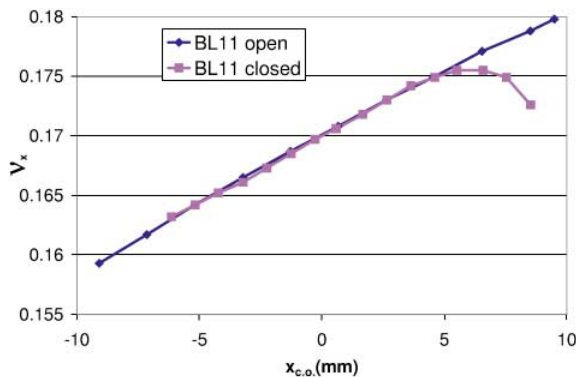
FIG. 13. (Color) Tune vs closed orbit bump in BL11 with magic